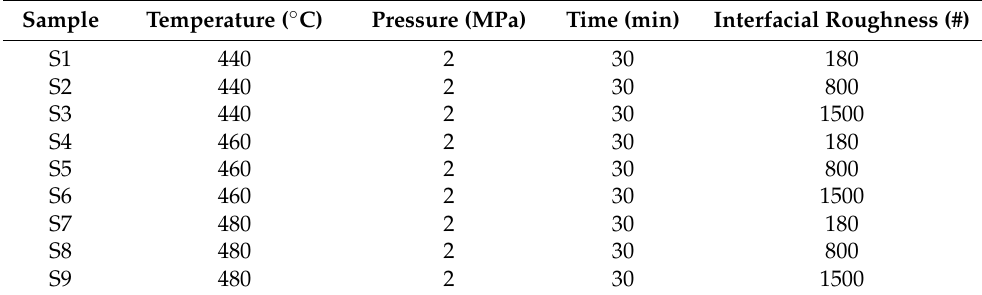
Figure 1. ( a ) Schematic diagram of the vacuum diffusion bonding, ( b ) Schematic diagram of shear test. Table 1. Diffusion bonding parameters in the present